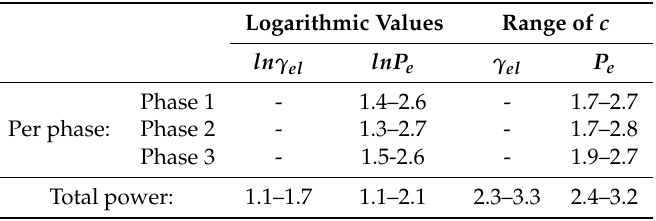
Table 4. Approximate optimal value of c according to different analysis and parts of the